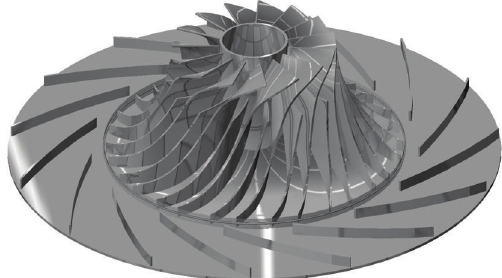
Figure 1: 3D sketch of the centrifugal compressor stage.